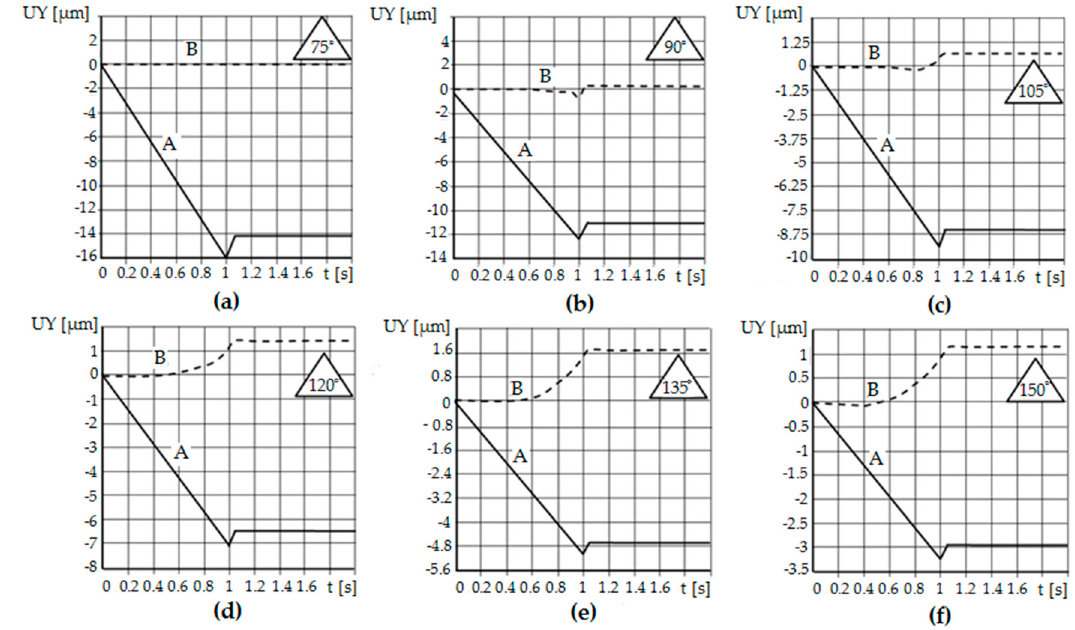
Figure 15. Diagram of displacement along the Y axis of selected asperity nodes with the vertical angle θ = 75° ( a ), θ = 90° ( b ), θ = 105° ( c ), θ = 120° ( d ), θ = 135° ( e ), θ = 150° ( f ), crushed with a flat punch: A—peak of asperity, B—bottom between asperities.